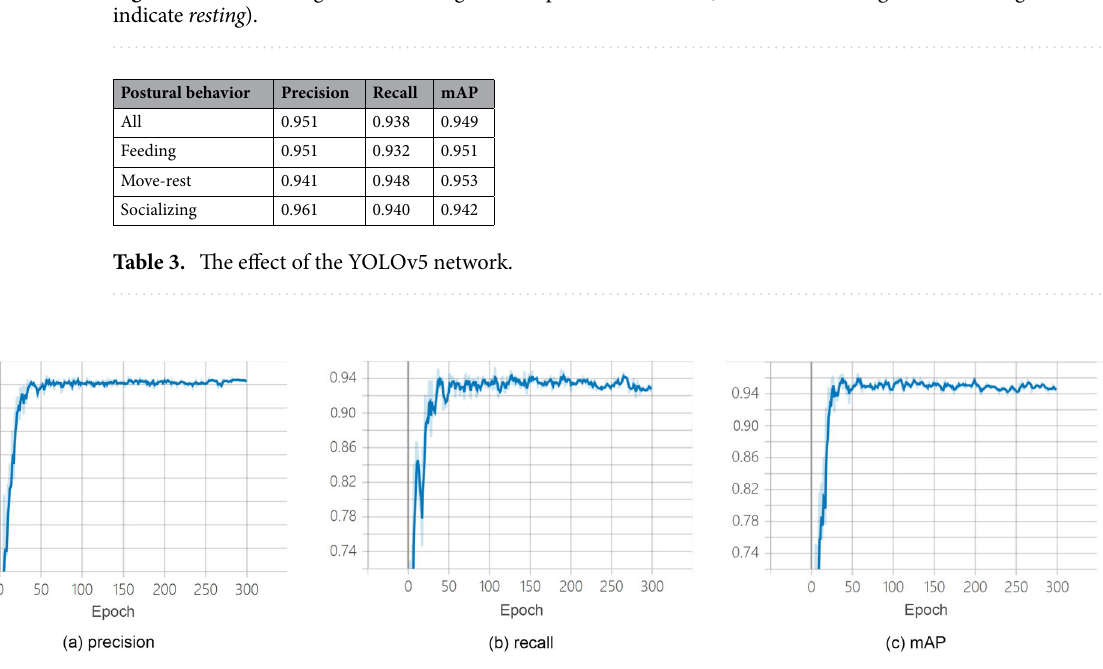
Figure 6. Precision, recall and mAP of object detection classification.